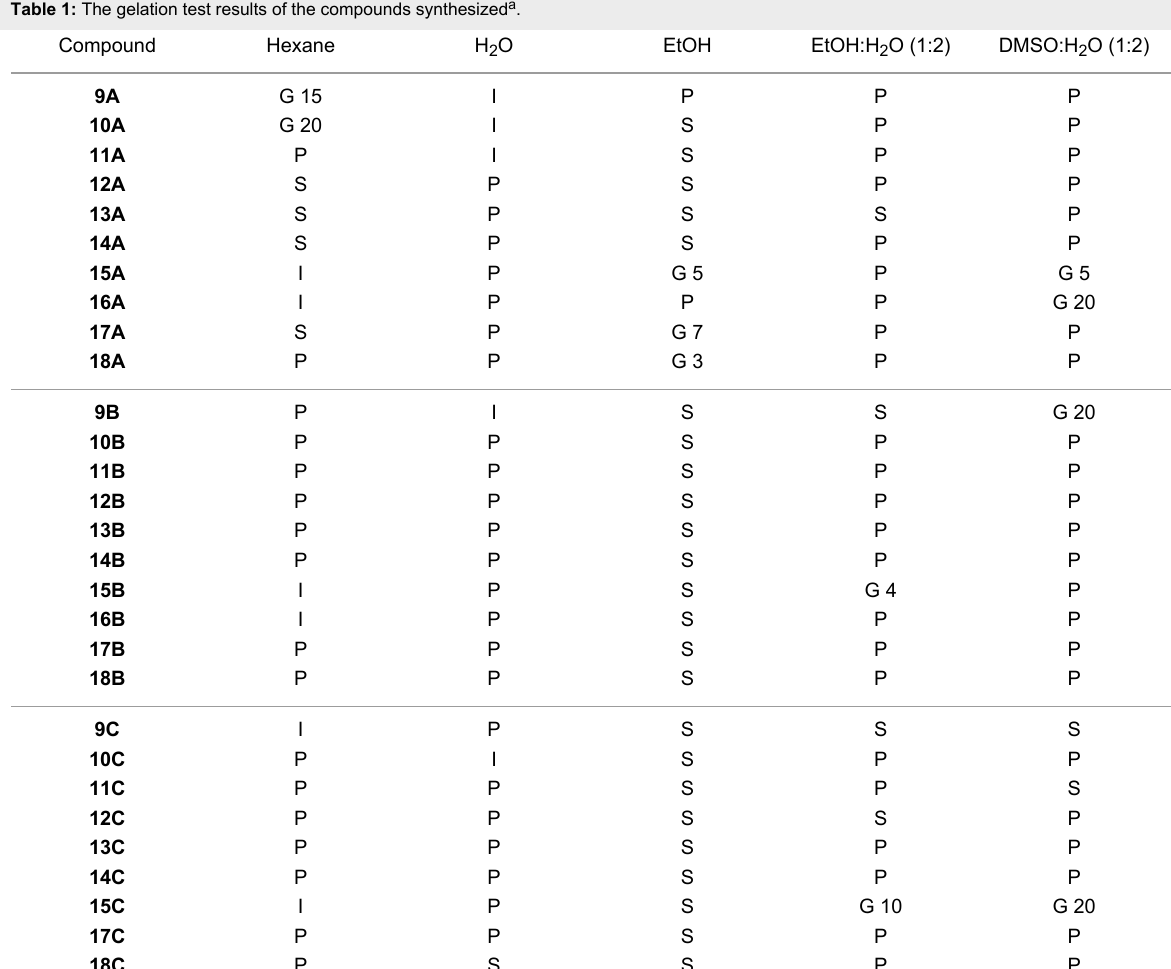
Table 1: The gelation test results of the compounds synthesized a